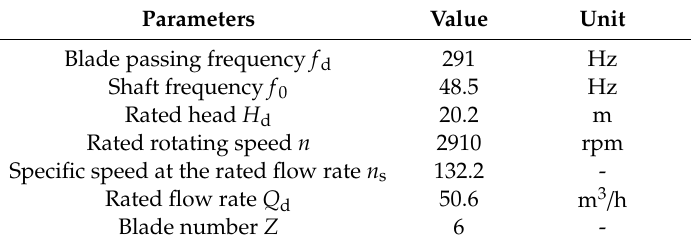
Table 1. Primary parameters of the centrifugal